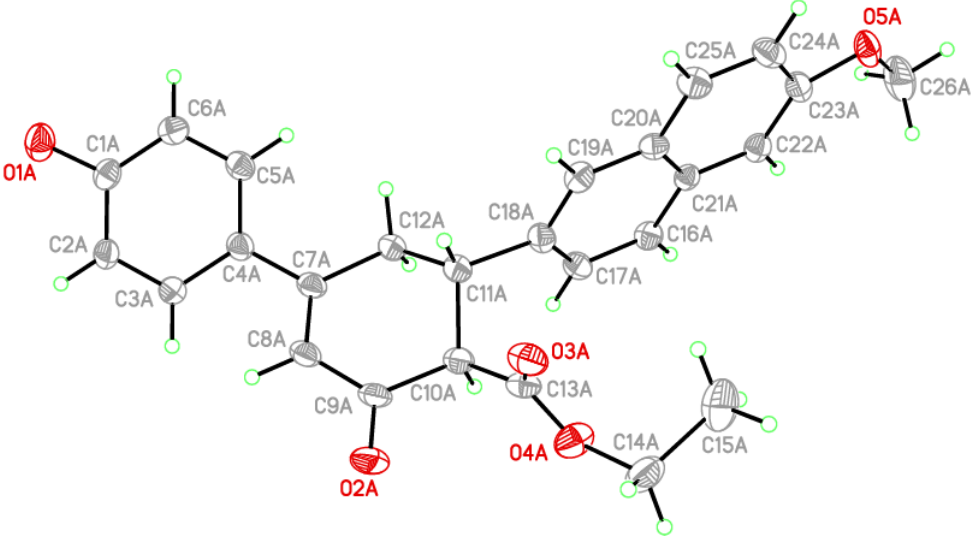
Table 1. Hydrogen bonds for ( I ) C